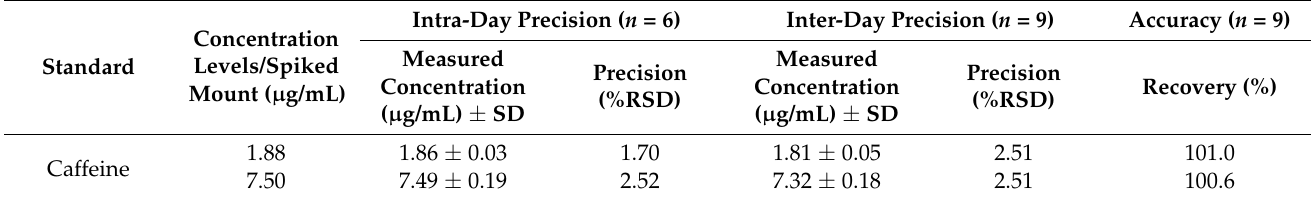
Table 5. Correlation coefficient ( r 2 ), linear range, LOD, and LOQ of the caffeine standard in the anti- Table 6. Intra-day and inter-day precision and accuracy of the HPLC method for determination of the caffeine standard cellulite emgel analyzed by HPLC. assessed at two different concentration levels ( n = 3) on three consecutive days. Accuracy was expressed as the percentage recovery of the caffeine standard at two different concentrations in the coffee extract.